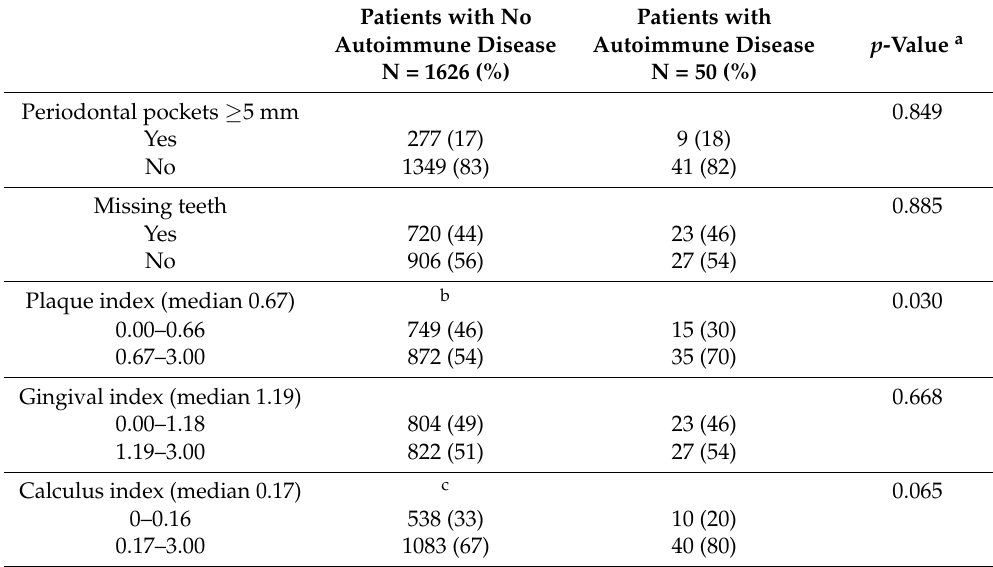
Table 2. Oral health status of the patients without and with autoimmune disease.